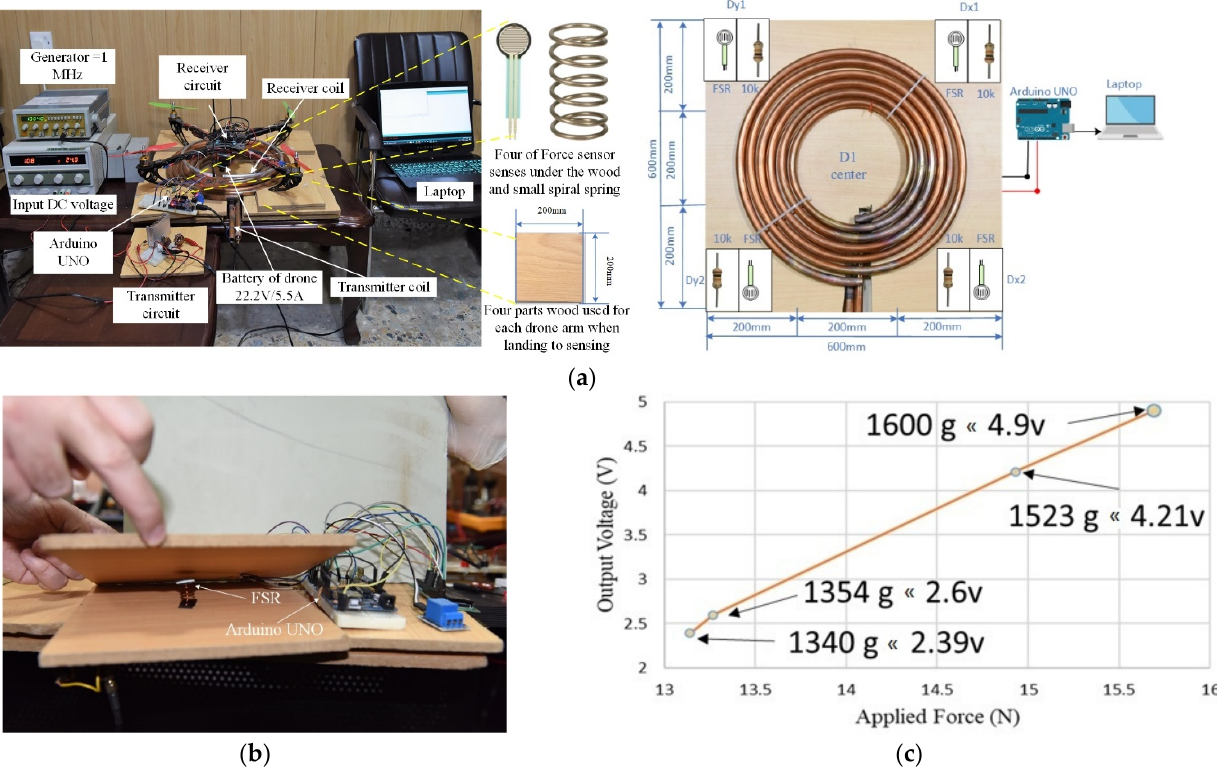
Figure 9. Small-wood testing of the solution with Arduino UNO before the start mission of: ( a ) a platform station using four FSRs; ( b ) FSR connected to Arduino Uno; and ( c ) the calibration of the FSR after drone landing.